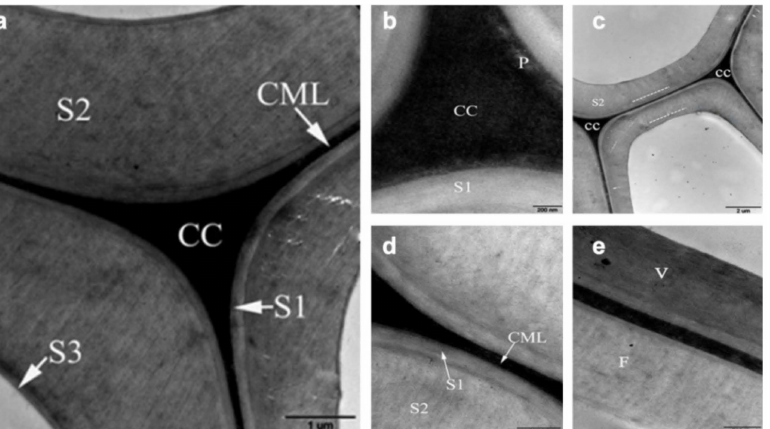
Figure 8. TEM images showing the heterogeneous distribution of lignin in poplar cell wall: ( a ) ultrastructure of adjoining fibers with different layers; ( b ) lignin concentration in the primary wall intermediates between CC and S1; ( c ) the outer and inner parts of the S2 layer appear more electron dense than the middle part; ( d ) the lignin distribution in the S1 and S2 layer is distinctly heterogeneous; ( e ) the lignification of vessel (V) is higher than fiber (V).